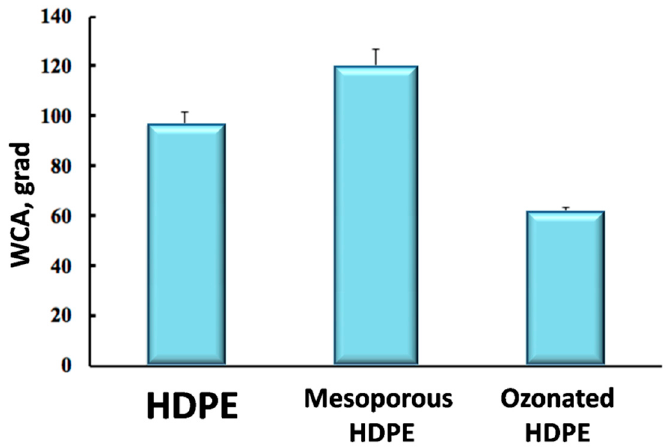
Figure 6. The diagram illustrating changes in WCA for pristine HDPE, MP HDPE membranes, and ozonated HDPE membranes (exposure 600 s).